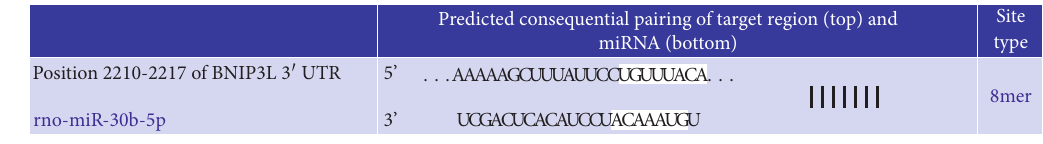
Predicted consequential pairing of target region (top) and miRNA (bottom)